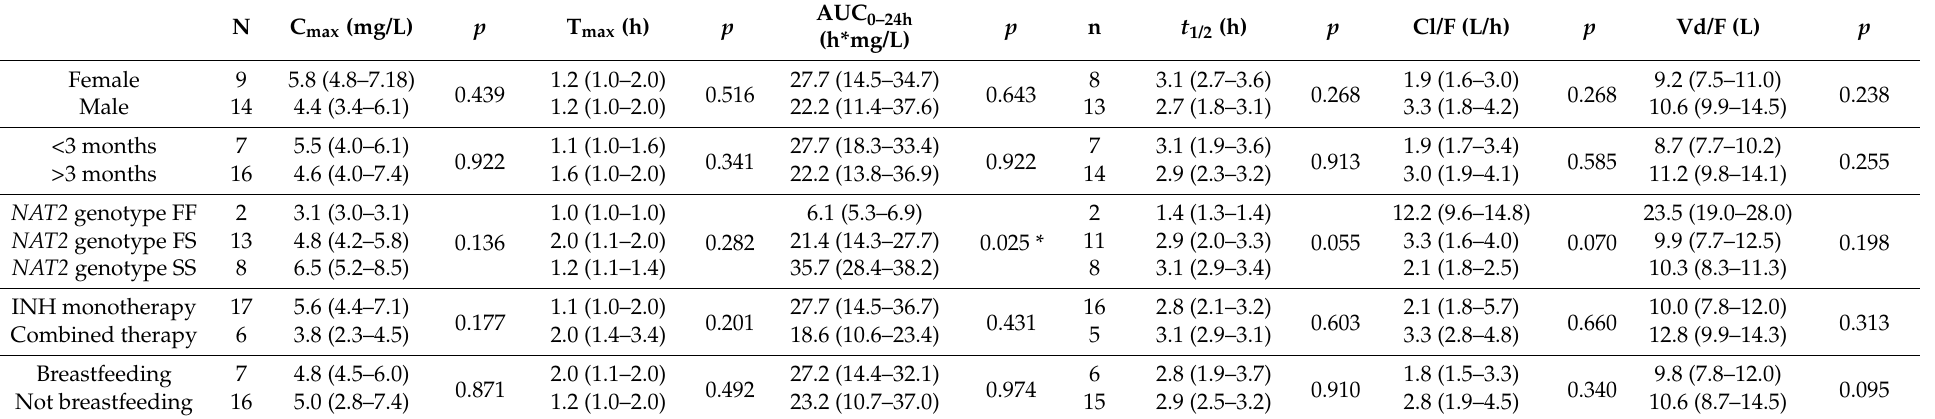
Table 3. Effect of different clinical characteristics on serum isoniazid pharmacokinetic parameters in the 23 assessments performed; all data are shown as medians (interquartile range). All data were analyzed using the Mann–Whitney U test, except for NAT2 genotype (Kruskal–Wallis